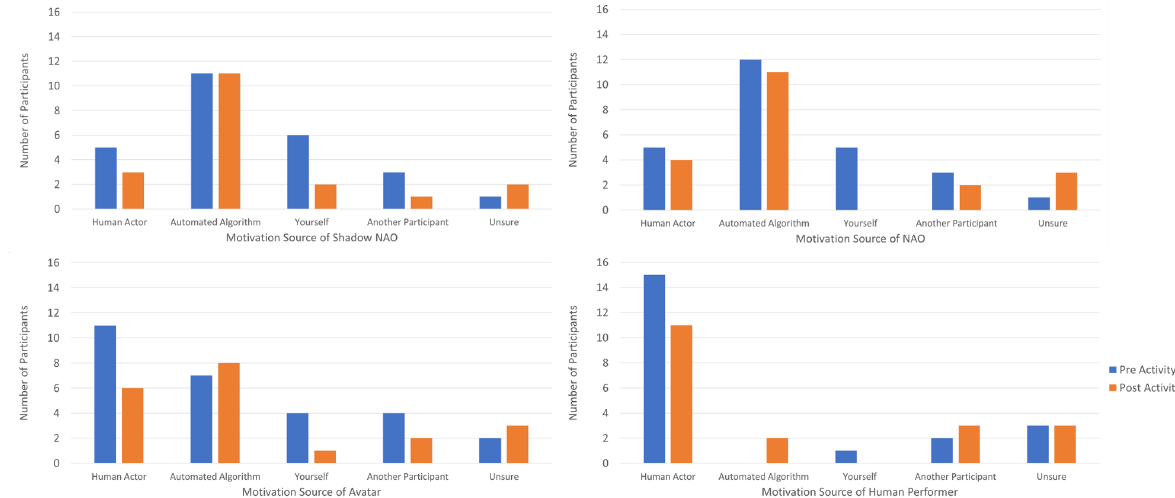
Figure 5: The perceived motivating source of each item in the installation rated by all Performance 5 participants. The two bottom charts, showing “Avatar Movement Motivation” and “Human Performer Movement Motivation,” show decreases in the Human Actor as motivation source from before to after the performance. This is notable as the Avatar was being driven directly by Another Participant in front of the Kinect sensor in the neighboring